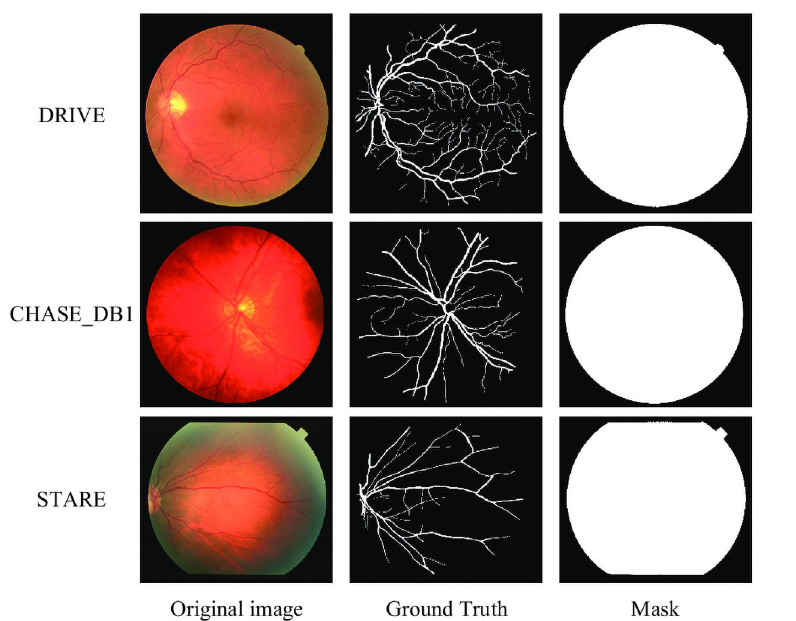
Fig 3. Sample images of DRIVE, CHASE DB1 and STARE datasets.